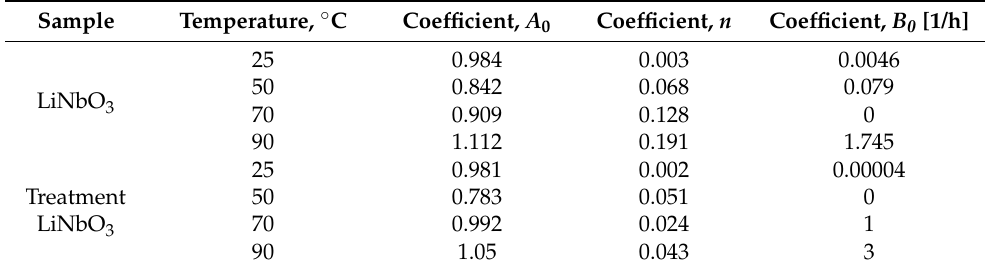
Figure 6. Arrhenius plots of experimental EO-modulators. Table 2. Calculated parameters on DC-drift of